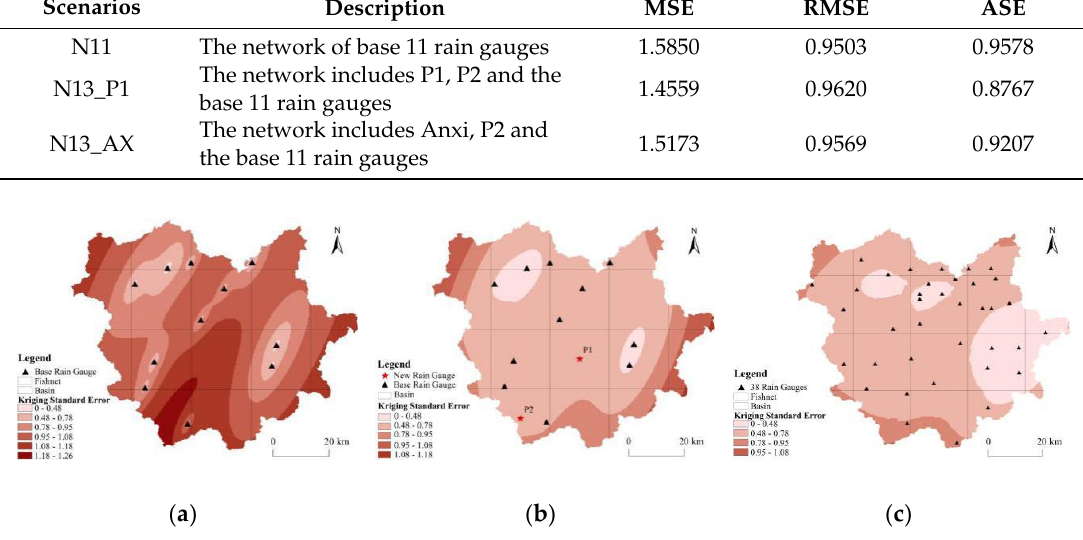
Figure 7. Kriging standard error (KSE) maps for the rain gauge networks. ( a ) Base rain gauge network (N11); ( b ) Optimal rain gauge network (N13_P1); ( c ) Original rain gauge network